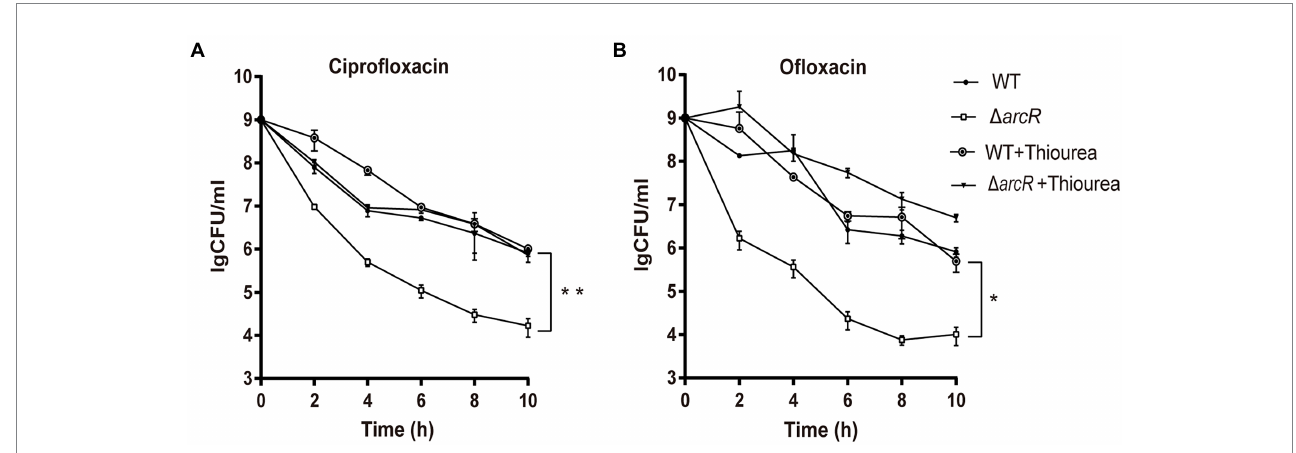
FIGURE 2 Effects of hydroxyl radical scavenger on bacterial resistance to fluoroquinolone antibiotics. Bacteria were treated with (A) 0.32 μ g/ml ciprofloxacin or (B) 0.5 μ g/ml ofloxacin in the presence or absence of 150 mM thiourea in TSB at 37 ° C with agitation. At the indicated times, the live bacterial counts were determined by serial dilution and plating. Error bars represent standard deviations. The data represent results from three independent experiments. * p < 0.05, ** p < 0.01, and *** p < 0.001 by Student’s t